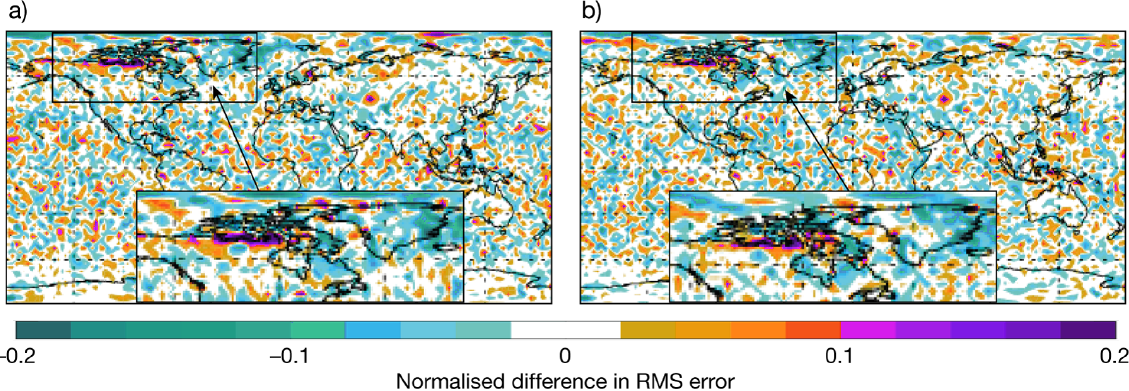
Figure 23. A 2 m temperature normalised root mean square error (RMSE) difference for northern hemisphere Summer between 4dvar simulations with the updated surface water map and the current operational version. The error differences refer to 36-h ( a ) and 48-h ( b ) forecasts initialized at